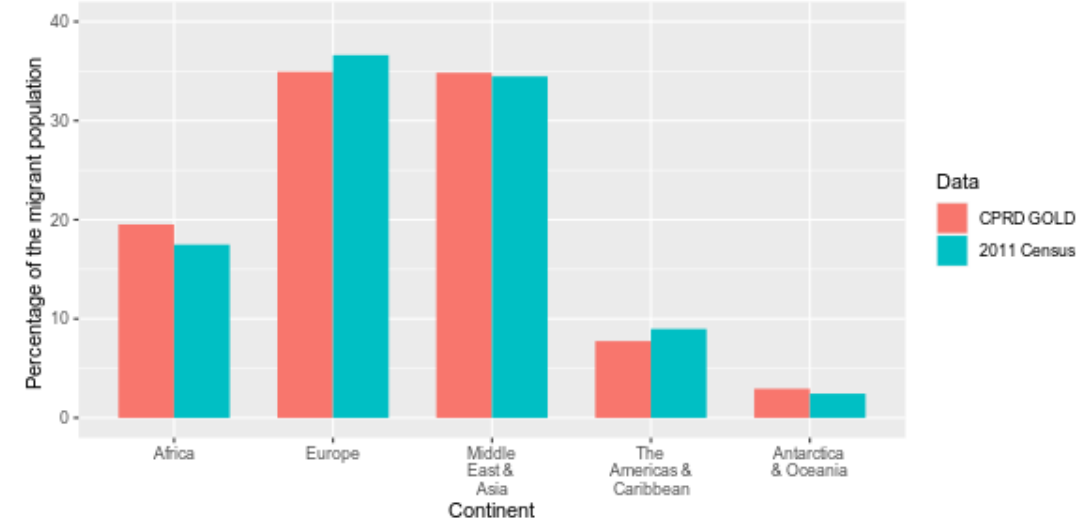
Figure 5. Percentage of migrants in CPRD (2011) and 2011 census according to continent of birth as defined by ONS Nomis.